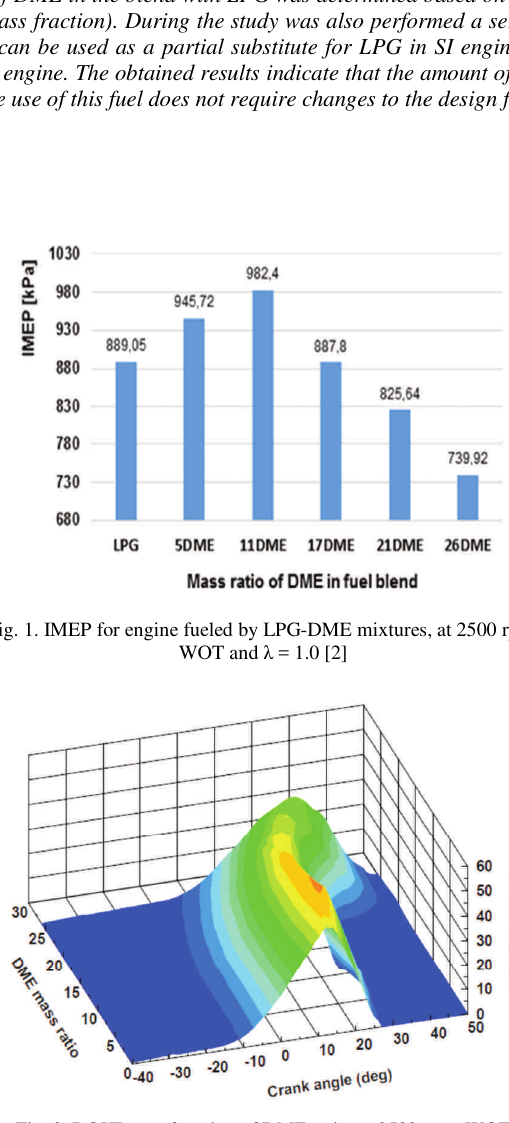
Fig. 2. ROHR as a function of DME ratio, at 2500 rpm; WOT and λ = 1.0